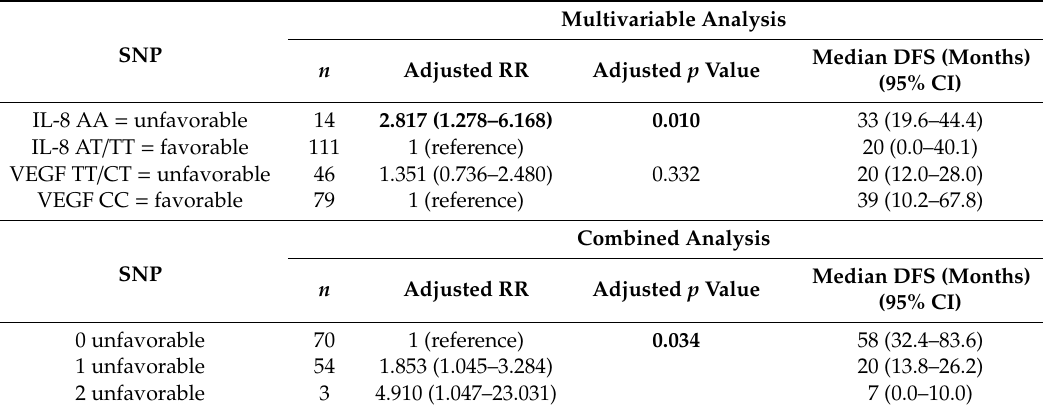
Table 5. Multivariable analyses of IL-8, VEGF, and